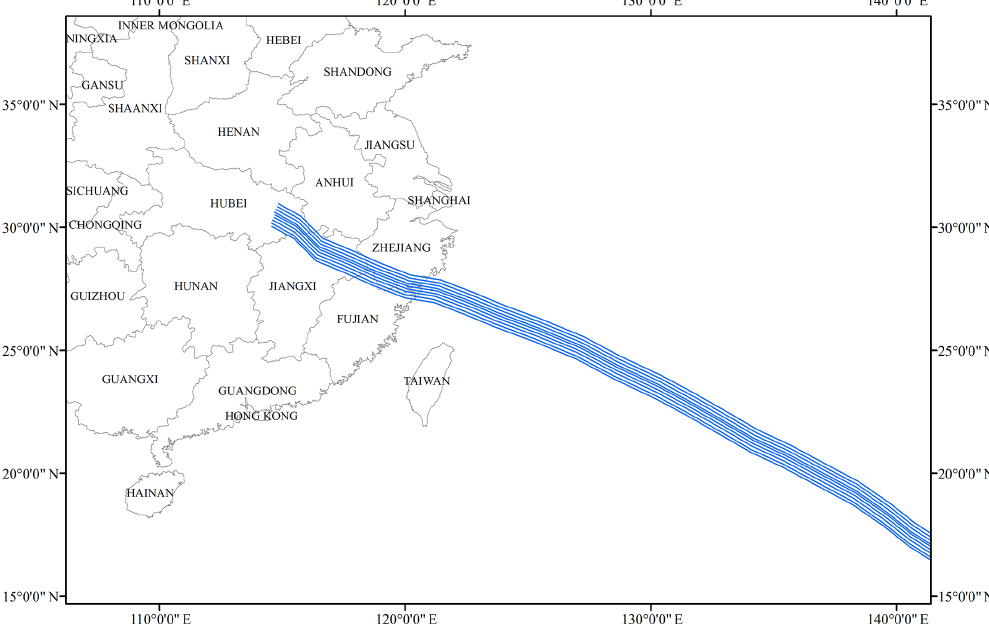
Figure 9. Designed-typhoon track set over Pingyang County. Table 4. Typhoon intensity